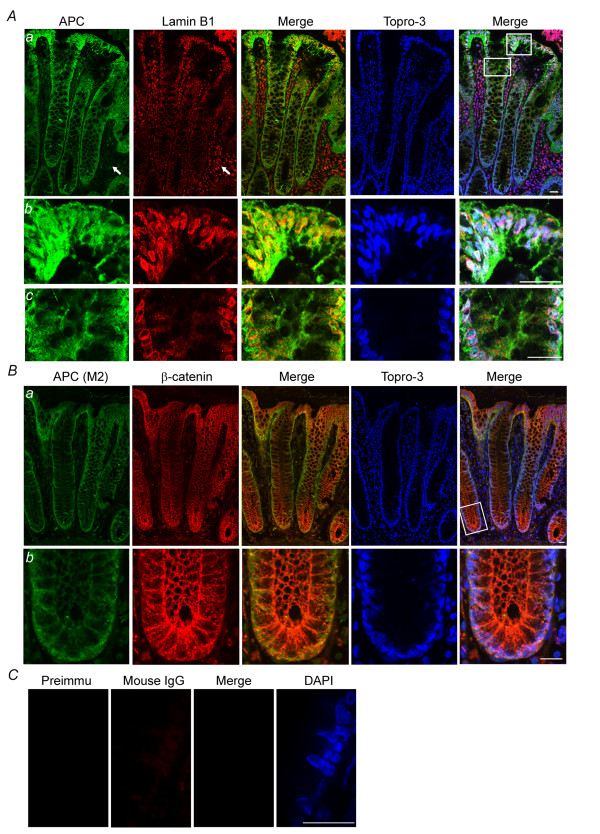
APC colocalizes with lamin B1 in human colonic tissue. (A) Confocal immunofluorescence microscopy of cryosections from normal human colon tissues triple-labeled with APC-M2 pAb (green), anti-lamin B1 (red) and DNA dye topro-3 (blue). Arrows point to stromal cells in which lamin B1 staining is more intense compared to adjacent epithelial cells within crypts. In contrast, less APC staining is detected in stromal cells compared to crypt epithelial cells. Tissues are oriented such that luminal surfaces are at the top of the images. (b) and (c) Enlarged images of two regions indicated in (a). (B) APC colocalizes with β-catenin in the cytoplasm and cell junctions of human colonic crypts. (b) Enlarged image of a region at the base a colonic crypt shown in (a). (C) Immunofluorescence microscopy using preimmune sera and purified mouse IgG to probe consecutive tissue sections revealed only minimal signal. Scale bars, 20 μm.